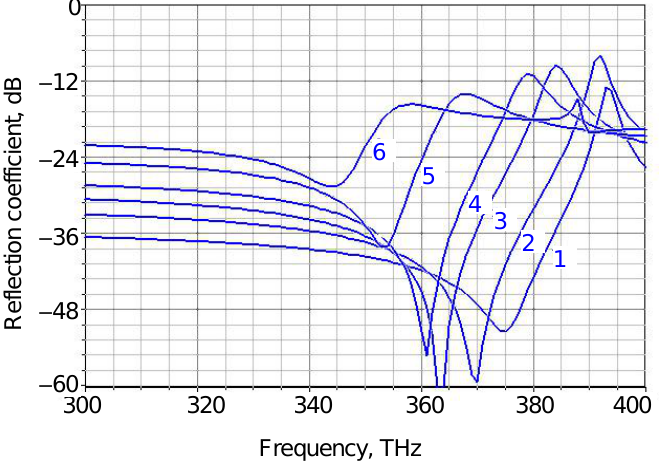
Figure 11. Spectral reflection for a fishnet PEC-dielectric-PEC with d values of dielectric thickness, (1) 20 nm; (2) 50 nm; (3) 75 nm; (4) 100 nm; (5) 150 nm and (6) 200 nm. Relative permittivity of dielectric ε = 2.